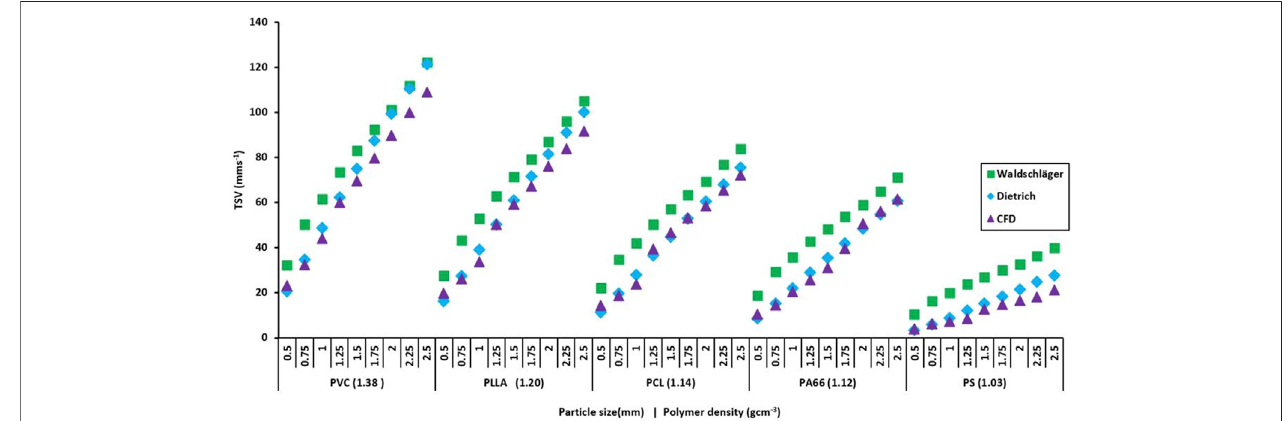
FIGURE 6 | Comparison of the CFD-simulated TSVs and the TSVs estimated using the Dietrich and Walsdschläger empirical relationships. The diameters of the spheres and the polymer types (and their densities in brackets) are shown on the x-axis.